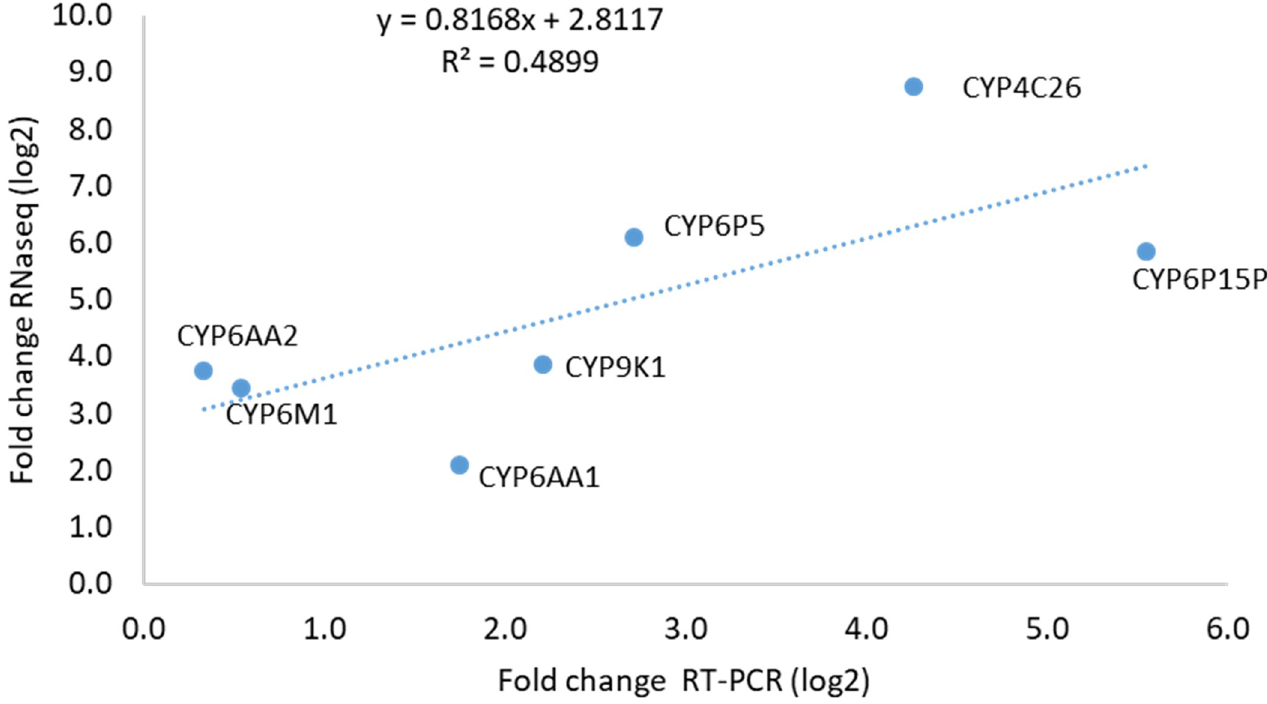
Fig 6. Correlation between RNA-Seq and qRT-PCR data of selected genes from the list of the up regulated transcripts.